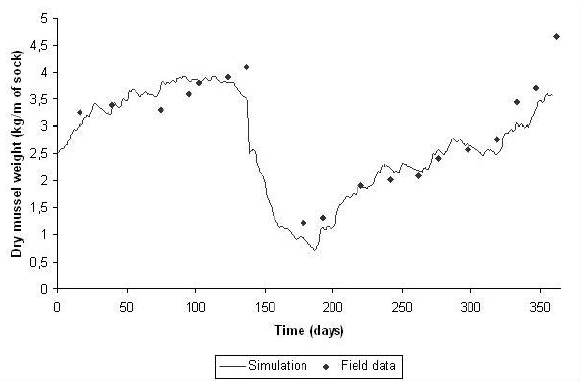
Fig. 4 . Mussel component calibration: observed and simulated dry weight.